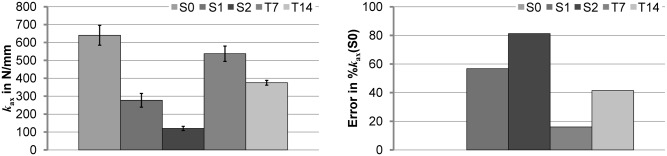
Axial compressive stiffness k
ax (mean±SD) (left) and the respective errors of the means (right) in relation to the reference mean value (i.e. respective mean axial stiffness of S0) for the five different model designs S0, S1, S2, T7, and T14).